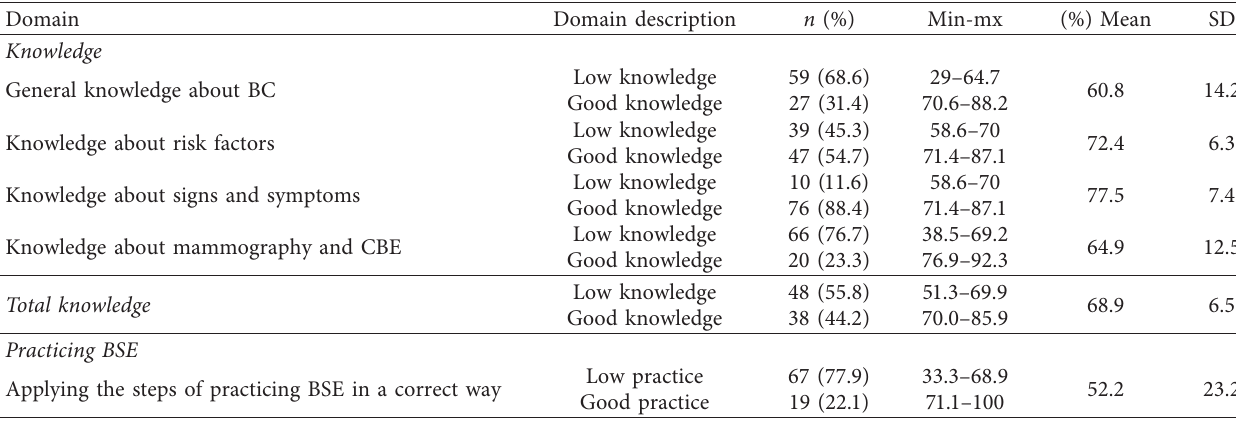
Table 3: Level of knowledge and practice.